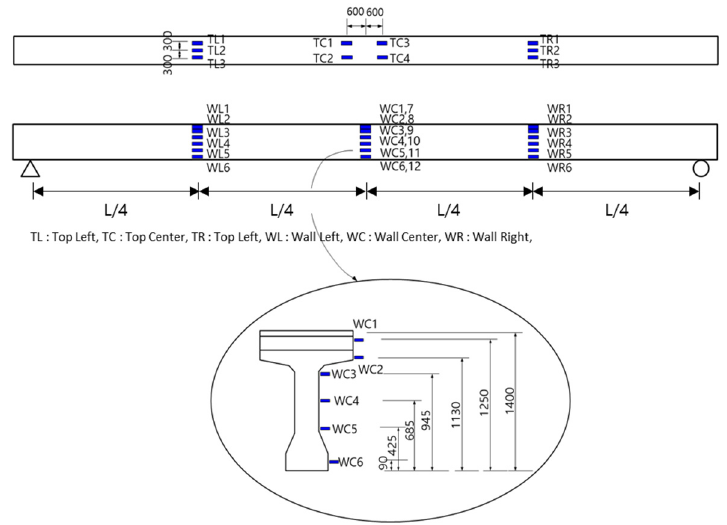
Figure 6. Positions of concrete gauges in the upper portion and on the side (NSM and EP methods).